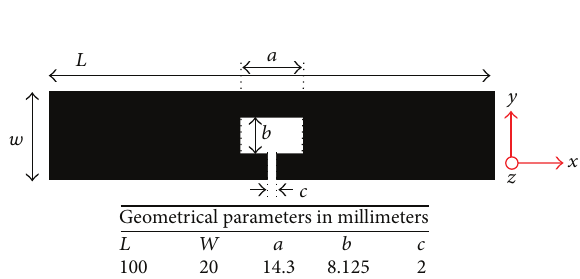
Figure 1: Brush-painting process.